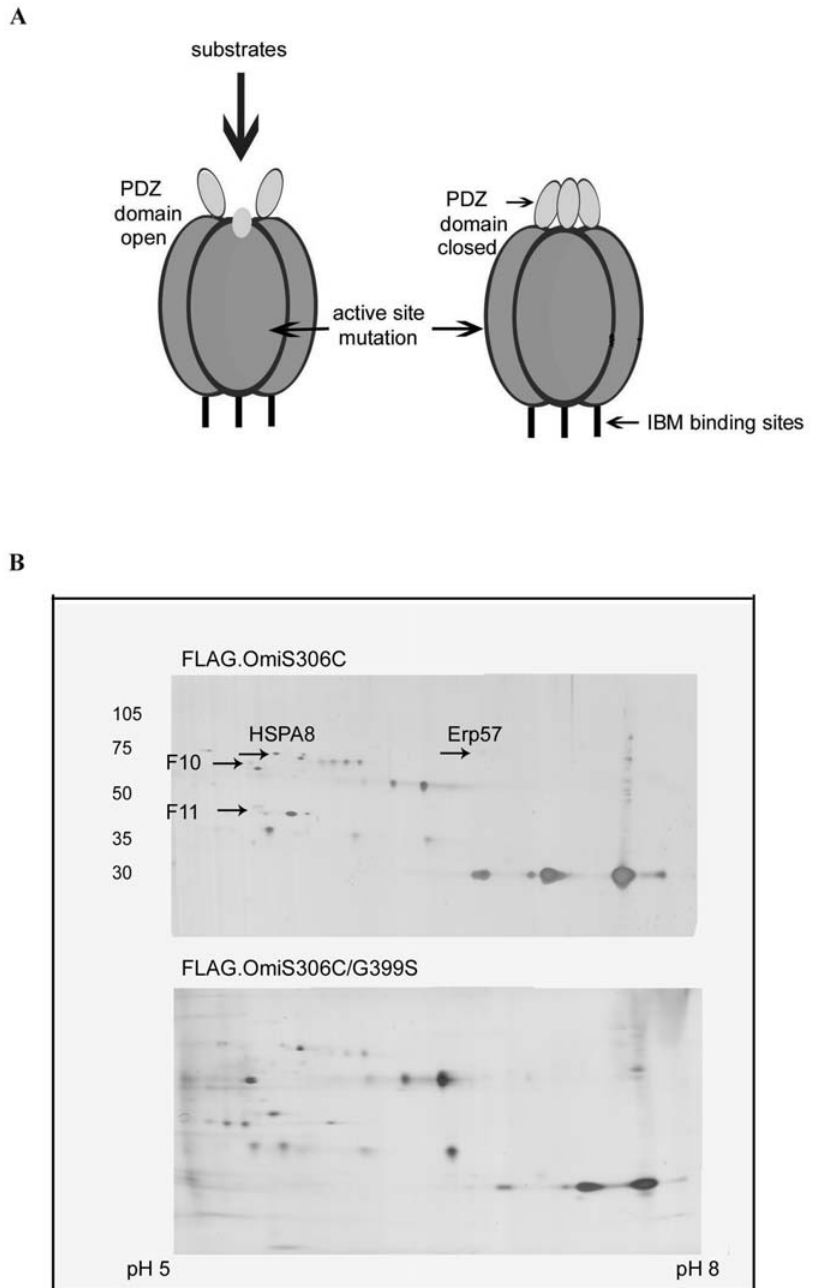
Figure 2. Results from the entrapment approach used to identify mitochondrial proteins interacting with OMI. A cartoon depicting OMI as a trimer with the regulatory PDZ domain (A). A representative silver stained IEF/2D gel of mitochondrial proteins from HEK293 cells transfected with FLAG-OMI mutant and immunoprecipitated with anti-FLAG beads (B). Arrows indicate the species that were unique to the OMI306 mutant but not common to both OMI.S306C and OMI.S306C/G399S.